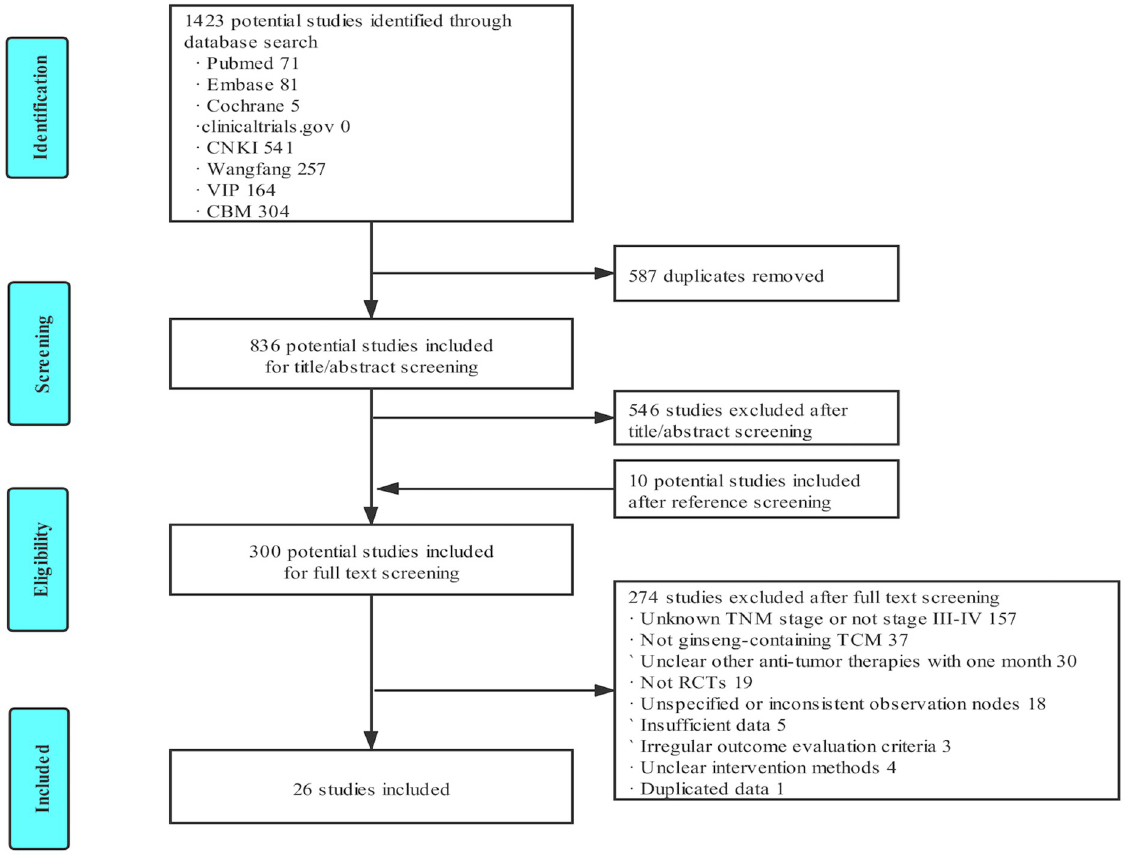
Fig 1. Flow diagram. TCM, traditional Chinese medicine; RCTs, randomized controlled trials.